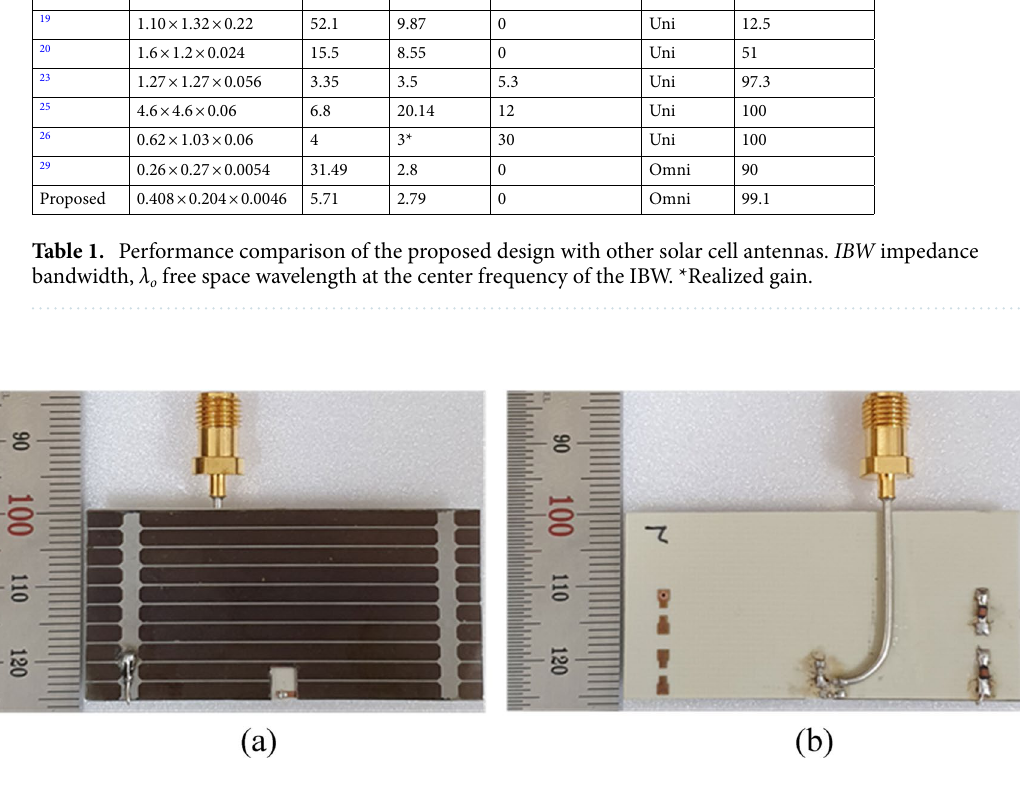
Figure 7. Photograph of the fabricated prototype: ( a ) top view and ( b ) bottom view.